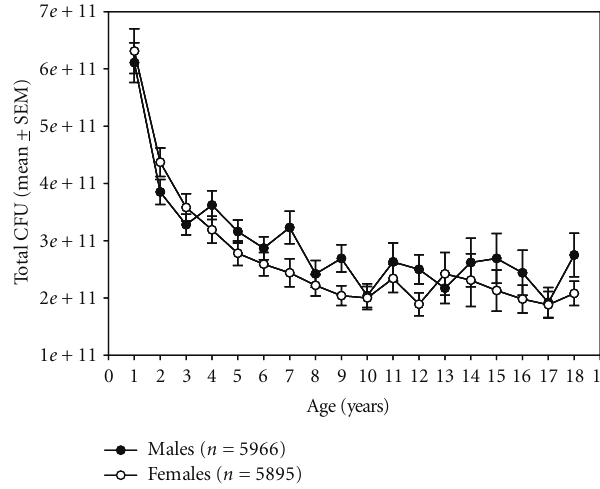
Figure 4: Total CFU (mean ± SEM) by age (years) and by gender.